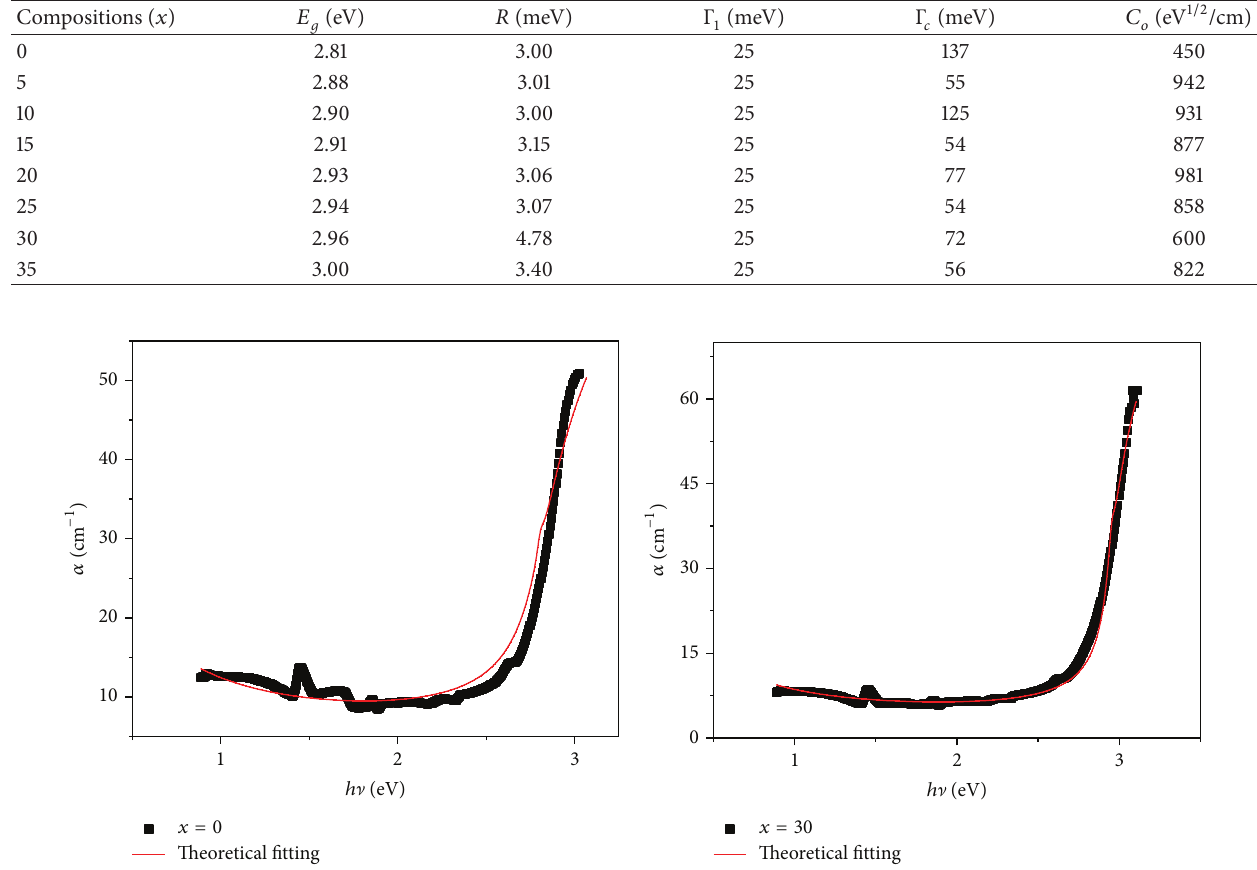
Table 2: Values of band gap ( 𝐸 𝑔 ), excitonic binding energy ( 𝑅 ), linewidths for 𝑚 = 1 state ( Γ 1 ), linewidth of continuum ( Γ 𝑐 ), and absorption strength ( 𝐶 𝑜 ) obtained from best fit to absorption spectrum using hydrogenic excitonic expression for 40SiO 2 ⋅ 𝑥 ZnO ⋅ (60 − 𝑥 )Bi 2 O 3 glass system.